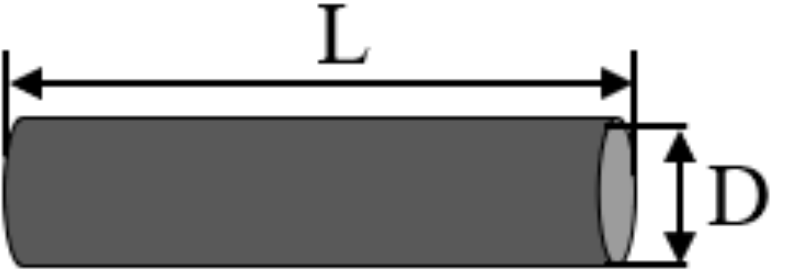
Figure 1. Physical model of the projectile.